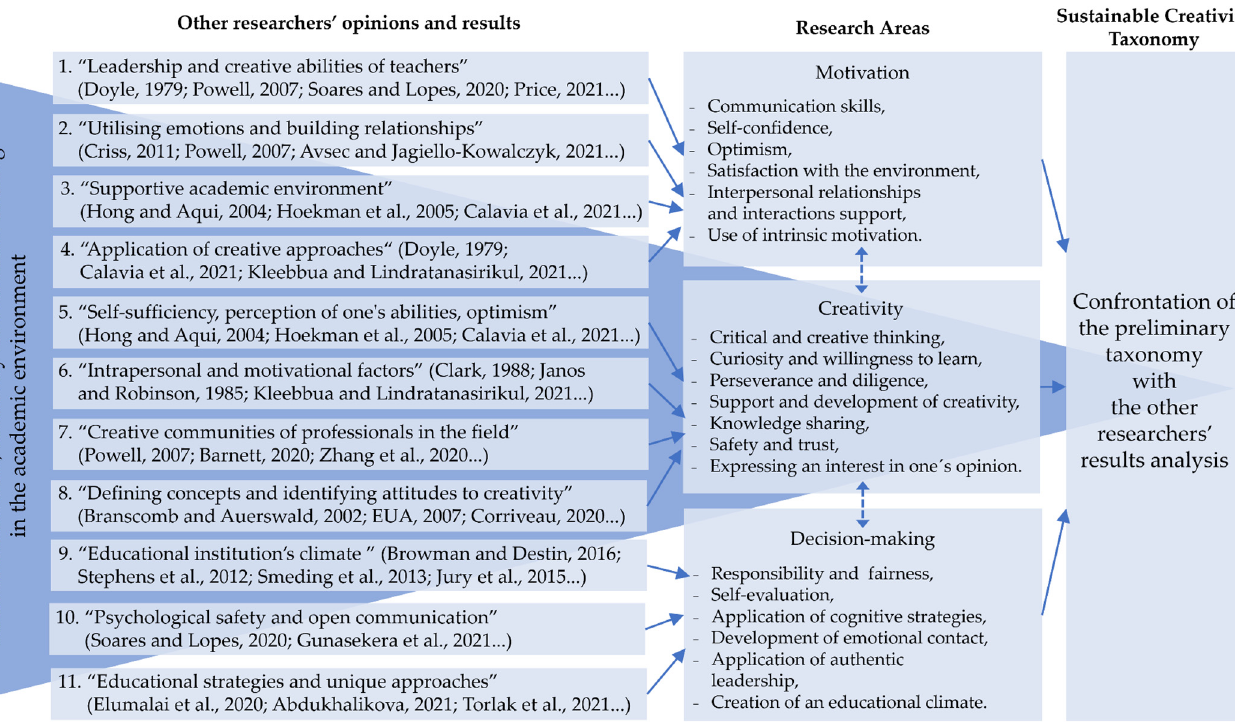
Figure A1. Other researchers’ opinions in relation to sustainable creativity taxonomy.